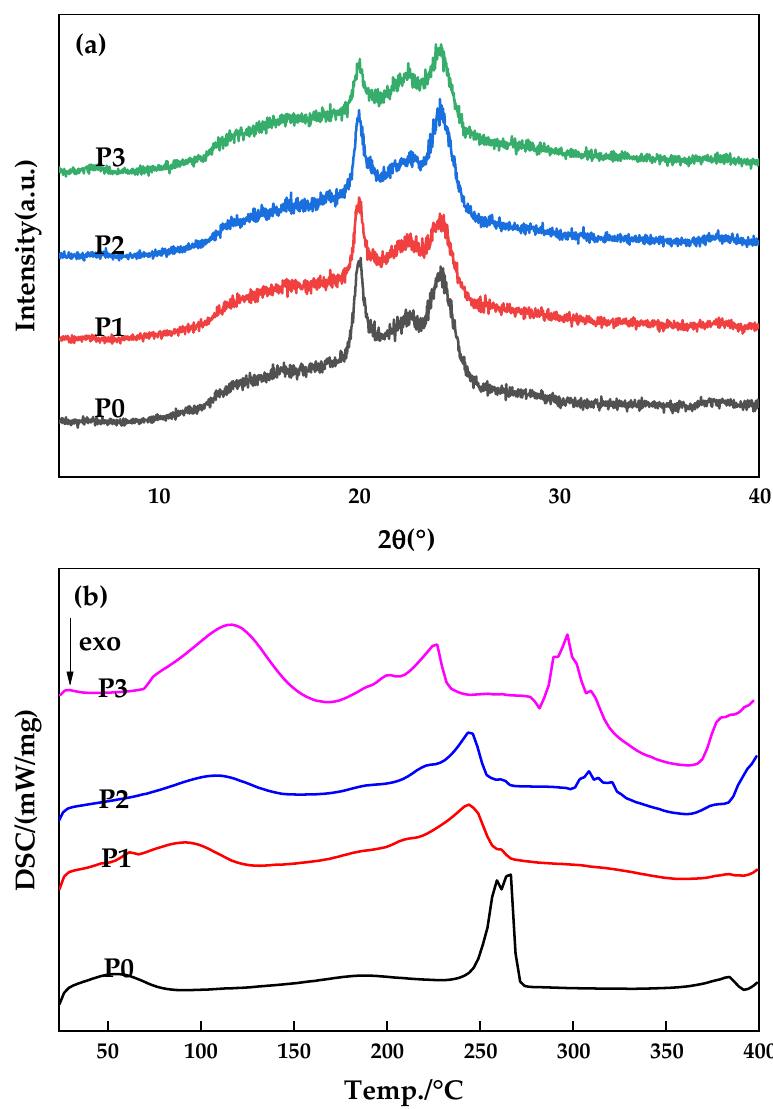
Figure 12. X-ray diffraction patterns ( a ) and DSC curves ( b ) of membranes obtained with different GO